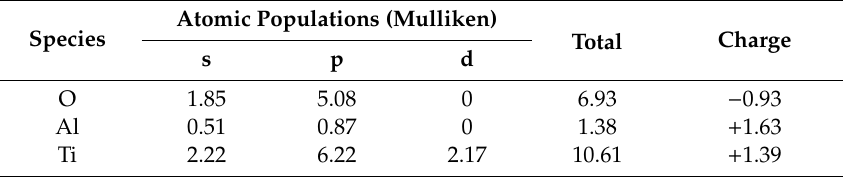
Table 2. Average Mulliken populations of atoms in Al 2 TiO 5 crystal.